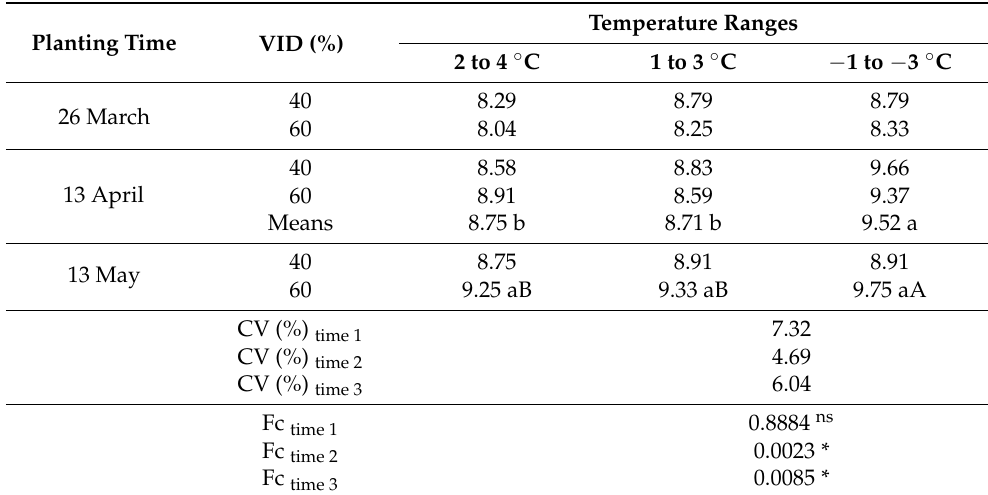
Table 6. Average number of leaves of garlic plants, Ito variety, at 75 days after planting (DAP), under different temperatures ranges and visual index of overcoming dormancy